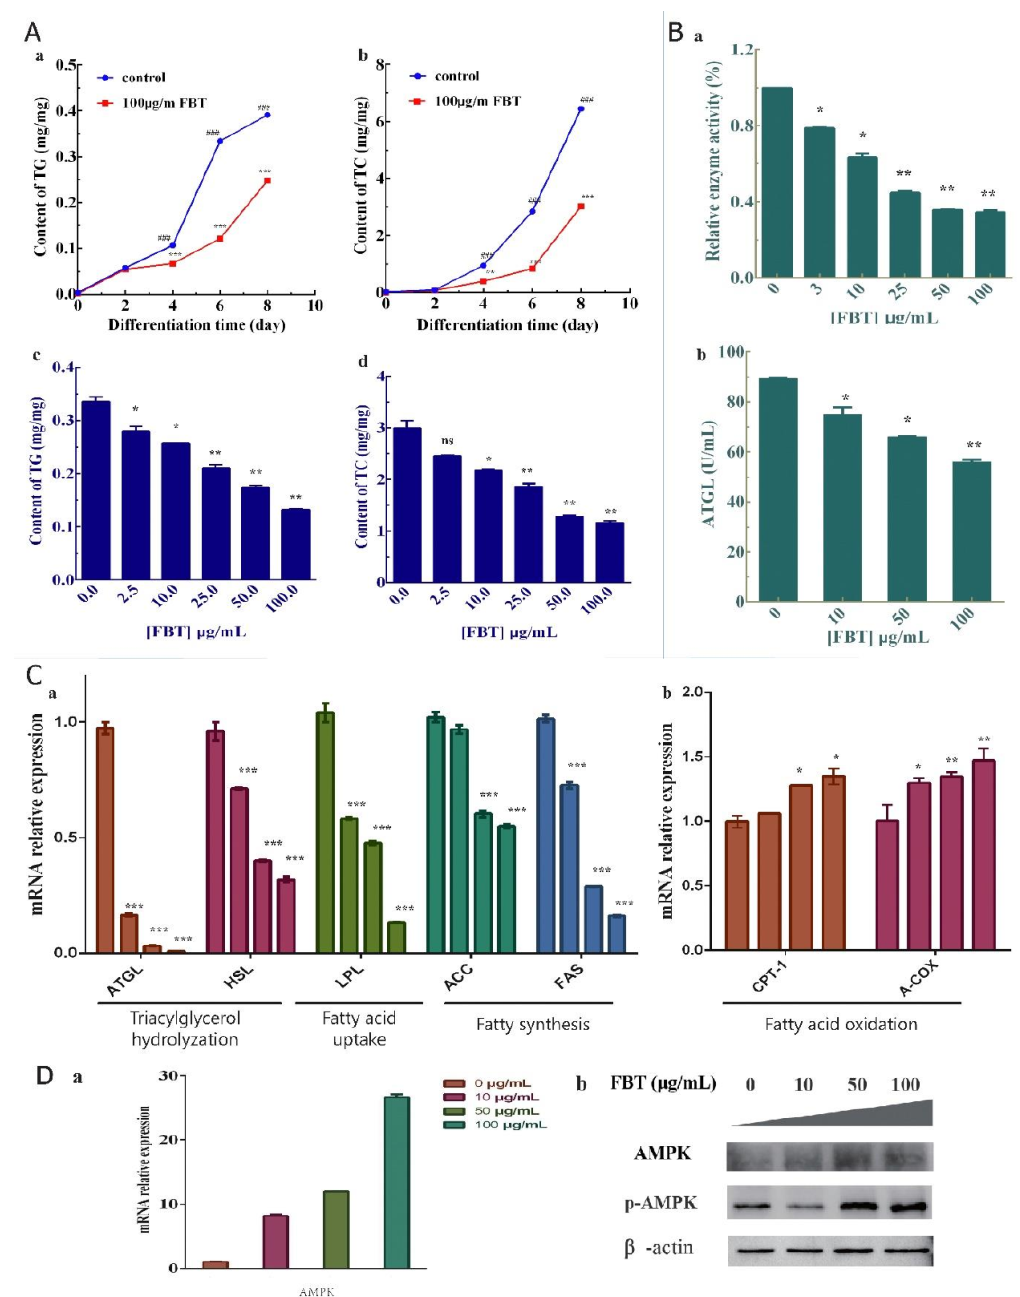
Figure 4. ( A ) The effect of FBT on the changes in TG and TC content during the differentiation of 3T3- L1 preadipocytes. ( A -( a,b )) Changes in TG and TC contents within eight days of the cell differentiation process under the 100 µ g/mL FBT treatment; ( A -( c,d )) The contents of TG and TC under different concentrations of FBT on the sixth day of differentiation. * p < 0.05, ** p < 0.01, and *** p < 0.0001 versus the control group; ### p < 0.0001 versus different times at the same concentration. ( B ) Effects of FBT on the related metabolism of 3T3-L1 cells. ( B-a ) 4-NPP was used as a substrate to detect lipase activity by UV spectroscopy. ( B-b ) ATGL activity detection results. ( C ) Lipid metabolism of 3T3- L1-related gene expression with FBT; ( C-a ) Gene expression related to triacylglycerol hydrolyzation, fatty acid uptake and fatty synthesis under FBT (0, 10, 50 and 100 µ g/mL) treatment; ( C-b ) Effects of FBT on the mRNA levels of genes related to fatty acid oxidation. ( D-a ), AMPK gene expression with RNA; ( D-b ), AMPK and phosphorylated AMPK protein expression with Western